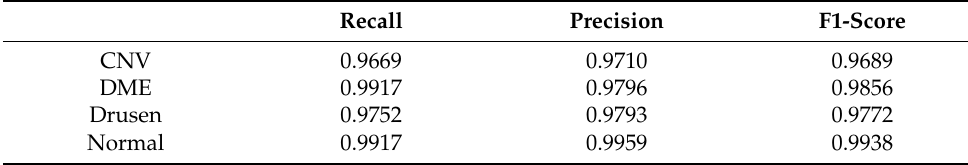
Table 6. CNN model with 7 hidden layers.